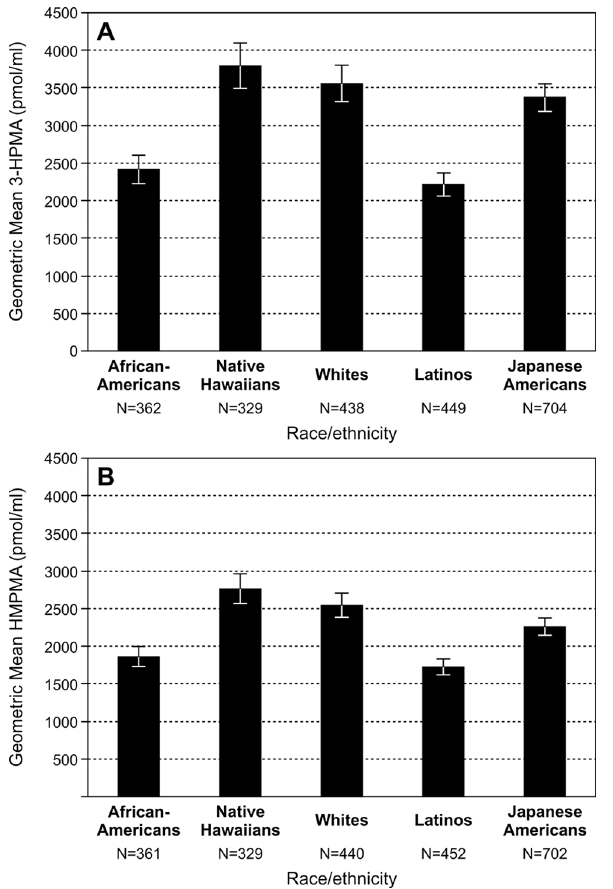
Fig 2. Geometric means of A. 3-HPMA and B. HMPMA in the five ethnic groups, after adjusting for age, sex, creatinine, and total nicotine equivalents.